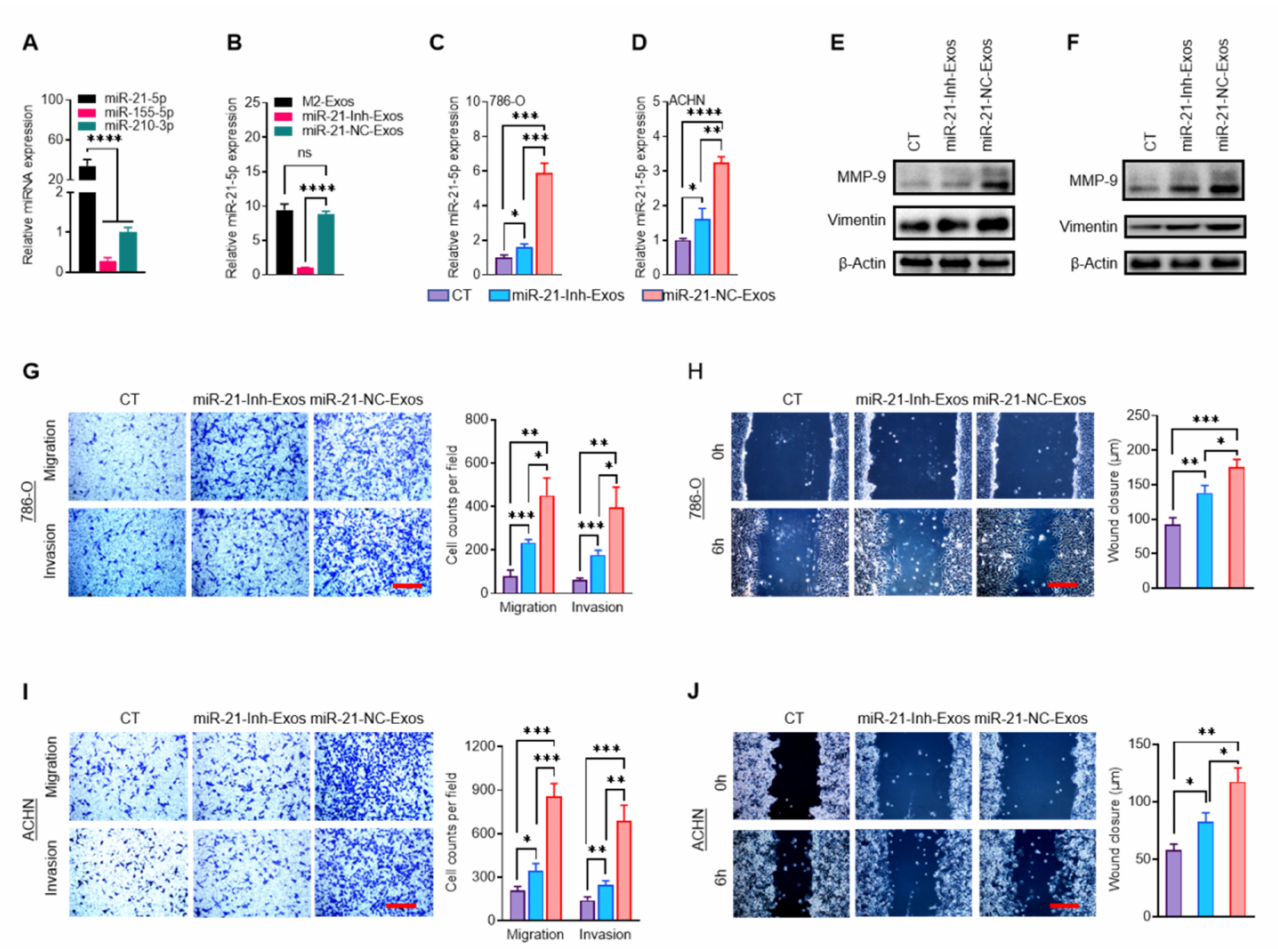
Figure 4. MiR-21-5p in M2-Exos promotes RCC migration and invasion in vitro. ( A ) The expression of three miRNAs in THP-1-M2 cells was analyzed by RT-qPCR. ( B ) The level of miR-21-5p expression in M2-Exos, M2-miR-21-Inh-Exos, and M2-miR-21-NC-Exos was assessed by RT-qPCR. ( C , D ) The intra- cellular content of miR-21-5p in 786-O and ACHN cells treated with control media, miR-21-Inh-Exos, or miR-21-NC-Exos was assessed by RT-qPCR. ( E , F ) The level of MMP-9 and vimentin in treated cells was assessed by western blotting. ( G – J ) The migration and invasion of treated cells were assessed by transwell ( G , I ) and wound-healing assays ( H , J ). Scale bar: 100 µ m. * p < 0.05, ** p < 0.01, *** p < 0.001, **** p < 0.0001, ns: not